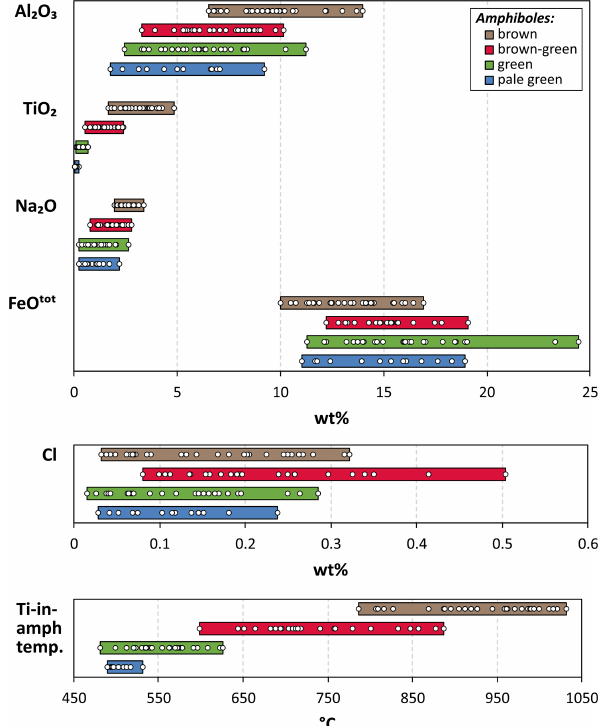
Figure 10. Compositional range (bars) and averages (white circles) for different amphibole groups in varitextured gabbros, classified by mineral color. The concentrations of Al 2 O 3 , Na 2 O, TiO 2 and hence the Ti-in-amphibole temperature range towards lower values from brown via brown-green and green to pale green color of the amphiboles. High TiO 2 contents in the brown amphiboles (up to ∼ 5wt%) reveal a magmatic origin. Relatively high Cl contents (up to 0.5wt%) imply the presence of a highly saline fluid or brine dur- ing formation, interpreted as the result of assimilation of previously hydrothermally altered sheeted dikes (see Discussion).